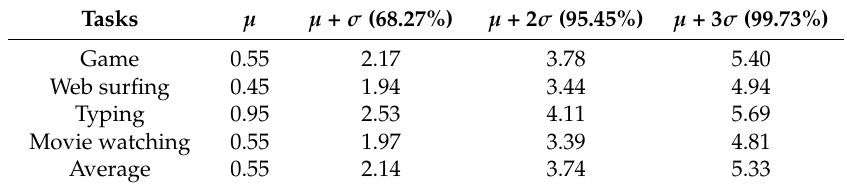
Table 6. Head movement velocities in 3D space based on Gaussian fitting analysis (in cm/s). Tasks